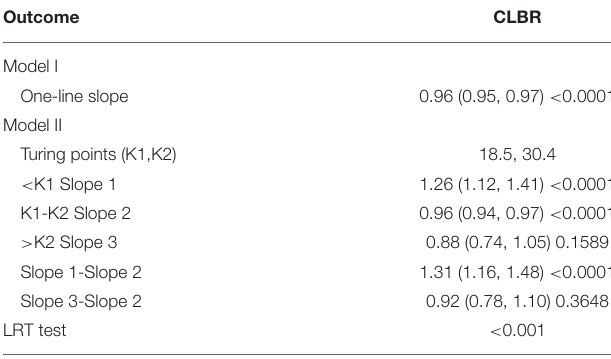
Results in table: OR (95% CI) P-value. Adjusted for female age, AFC, main etiology, OS protocol. Created by EmpowerStats (www.empowerstats.com) and